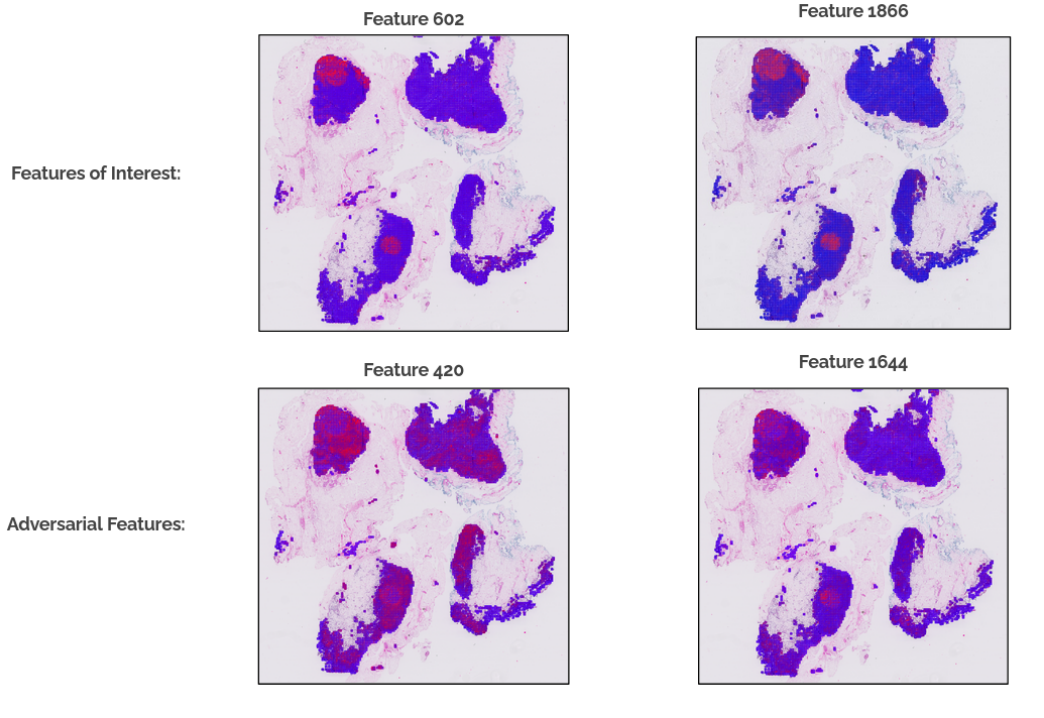
Figure 11. Contributing feature activation over